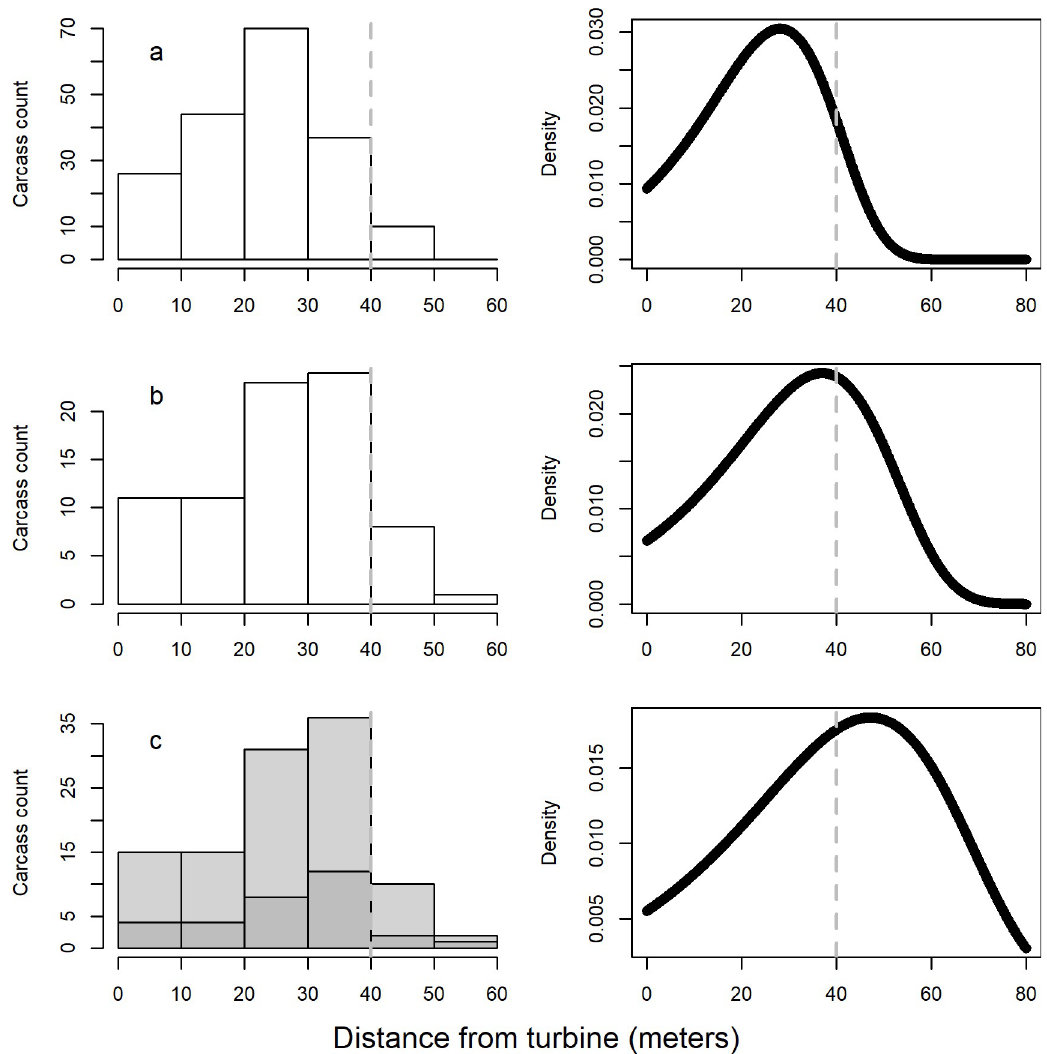
Fig 1. Distances of carcasses from turbine bases, and fitted curves describing the carcass density distribution. Model selection indicated Gompertz density distributions as the best fit in all cases. Grey dashed vertical lines on the plots indicate the 40-m threshold beyond which search effort decreased because only the corners of the square plots were searched beyond 40 m. Data were collected at 10 control turbines (Control; panel a), 10 wind speed-only curtailed (WOC) turbines with a cut-in speed of 4.5 m/s (panel b), and 10 Turbine Integrated Mortality Reduction (TIMR) system-curtailed turbines (panel c). Panel c indicates locations of the carcasses collected at the TIMR plots in dark grey bars, and the combined WOC + TIMR data used to fit the model in light gray bars, because the TIMR-only data produced an implausible carcass density distribution. resulting in a 94% persistence probability for our daily search regime. Area correction values for control and WOC treatments were 0.92 (90% CI: 0.87, 0.95) and 0.72 (90% CI: 0.37, 0.89), respectively. However, the area correction value for the TIMR treatment was implausibly low (much less than 0.01) because the right-truncated carcass distance data for this treatment did not clearly include the mode of the distribution (Fig 1). The TWL fitting method for carcass density distributions is prone to failure when the search radius is insufficient to capture the mode of the carcass fall distribution [25]. We combined carcass distance data from the TIMR treatment with distance data from the WOC treatment and obtained an area correction value of 0.51 (90% CI: 0.18, 0.87). This value is probably too high, so our estimate of fatality for the